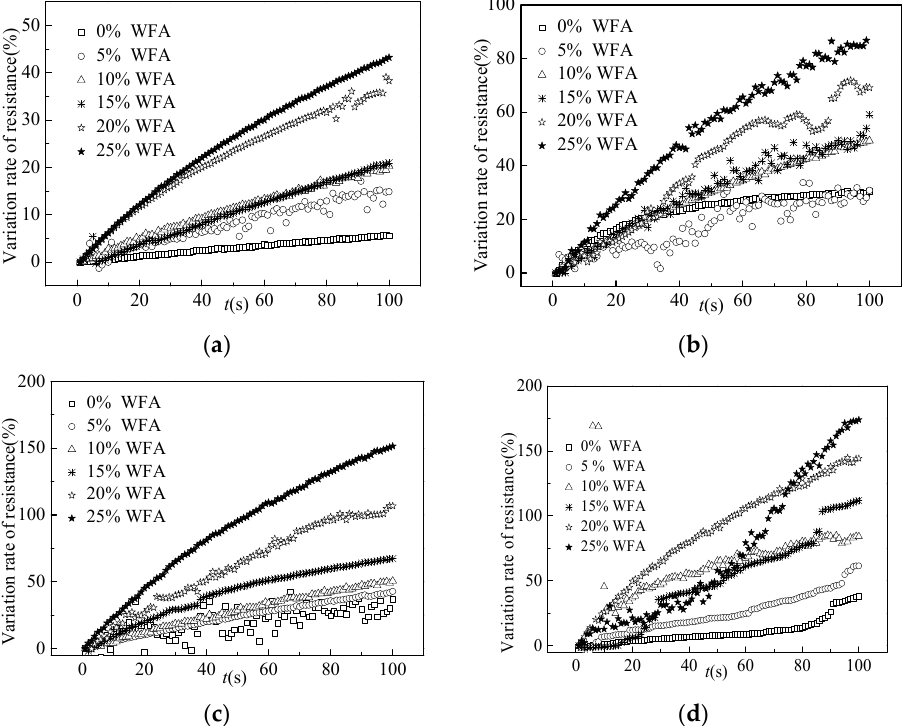
Figure 6. DC electrical resistance–time curves of cement paste with different dosage of waste fly ash. ( a ) 1 d, ( b ) 3 d, ( c ) 7 d, ( d ) 28